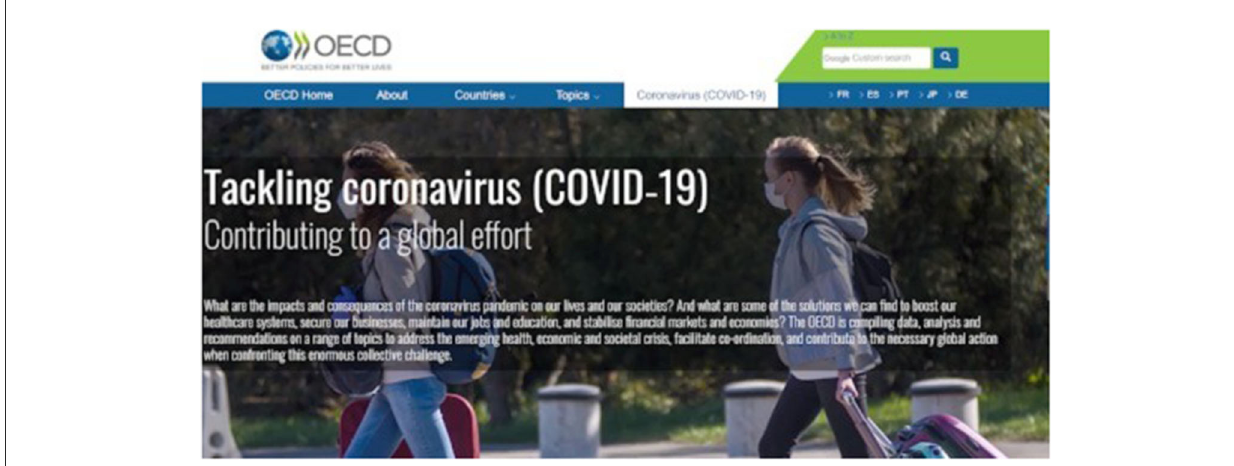
FIGURE1 Website of the Organization for Economic Co-operation and Development (OECD), whose goal is to increase cooperation and solidarity between countries. http://oecd.org/coronavirus/en/.